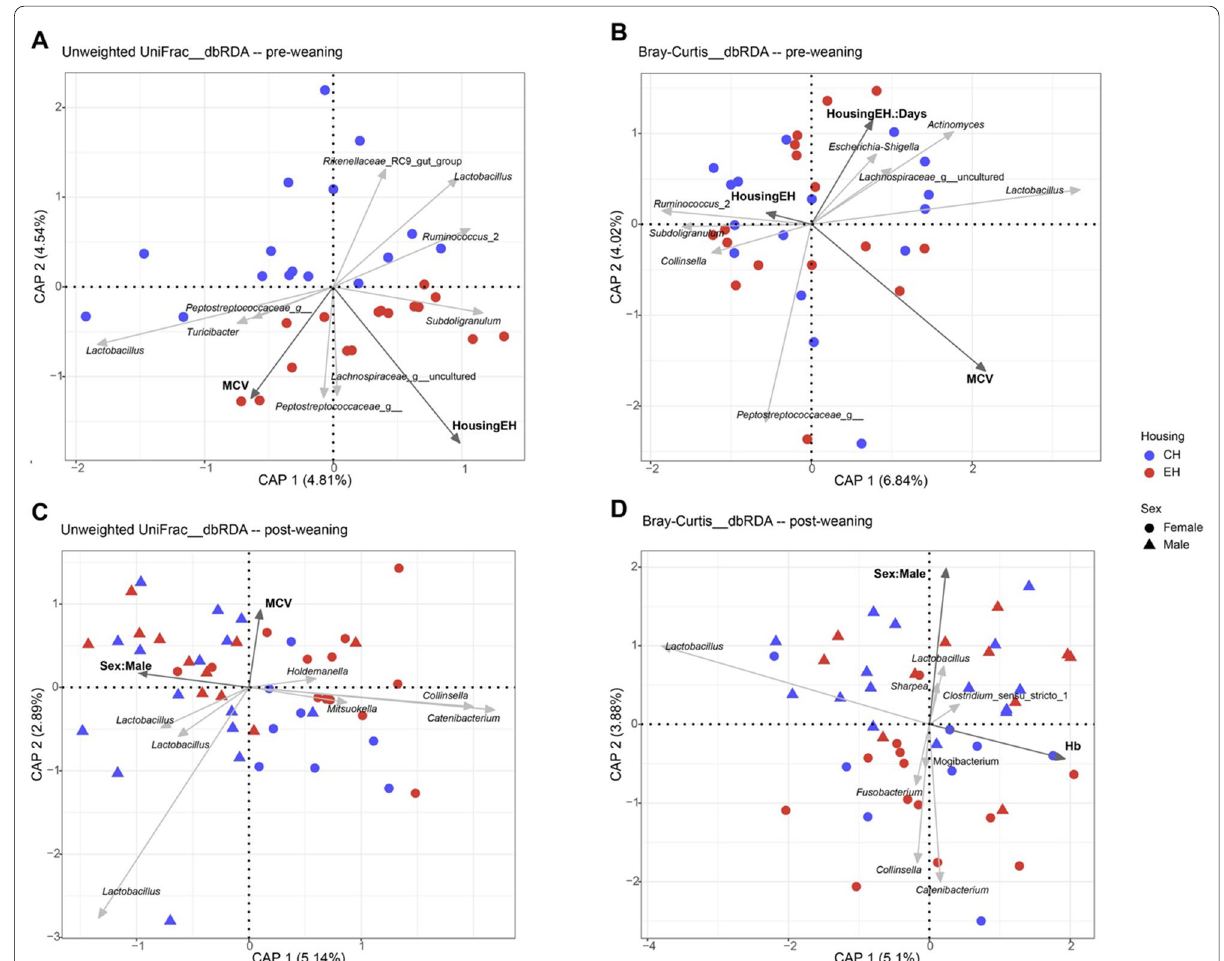
Fig. 5 Distance‑based redundancy analysis (db‑RDA) triplot showing the association between faecal microbiota variation and environmental variables. A , B Focusing on samples from pre‑weaning (day 12 and day 26), C , D samples from post‑weaning (day 33, day 47 and day 61). Colours represent different housing conditions (conventional housing: CH; enriched housing: EH) and shapes show different sex. Dark grey arrows indicate environmental variables and light grey arrows ASVs for which the model provided the best fit for the observed variation. The factor time (Days) was taken as the conditional variable in db‑RDA